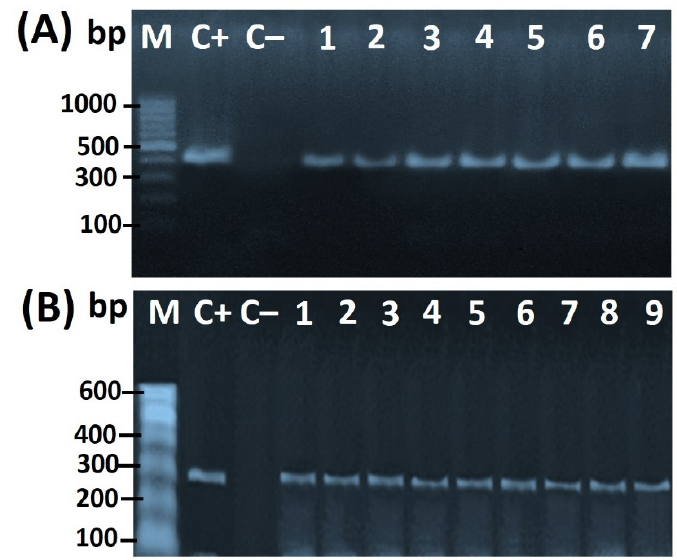
Figure 2. ( A ) Agarose gel electrophoresis of PCR amplicon (447 bp) of the 16S rRNA specific for H . pullorum strains (lanes 1–7). ( B ) Agarose gel electrophoresis of PCR product of glmM gene (294 bp) specific for the characterization of H. pylori strains (lanes 1–9). Lane M: 100 bp ladder as a molecular- size DNA marker. Lane 1: H. pylori positive control for the glmM gene. Lane 2: negative control from E . coli K12DH5 α . Lanes from 1 to 9: positive H. pylori strains.